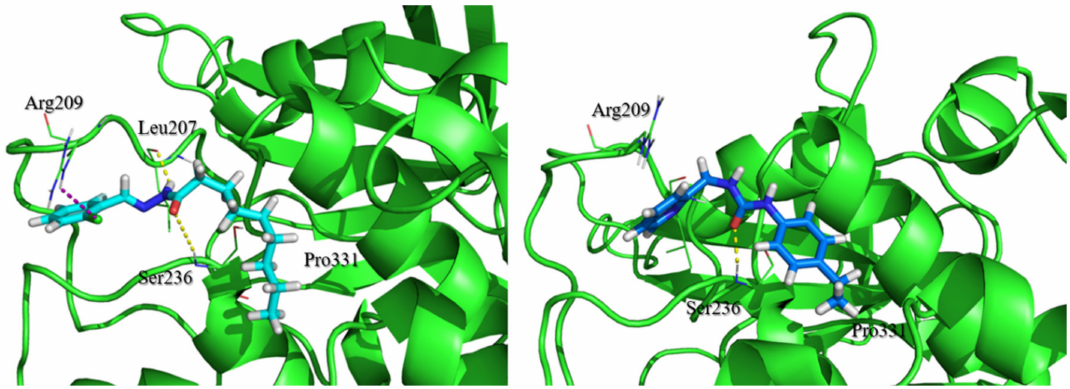
Figure 9. Representation of docked poses of LCQFGS01 and LCQFGS02 within GSK-3 β (1PYX.pdb) allosteric Cavity 7, obtained by Glide-developed docking protocol. Hydrogen bonds in yellow, and halogen bonds in purple. Images produced in Pymol [22].